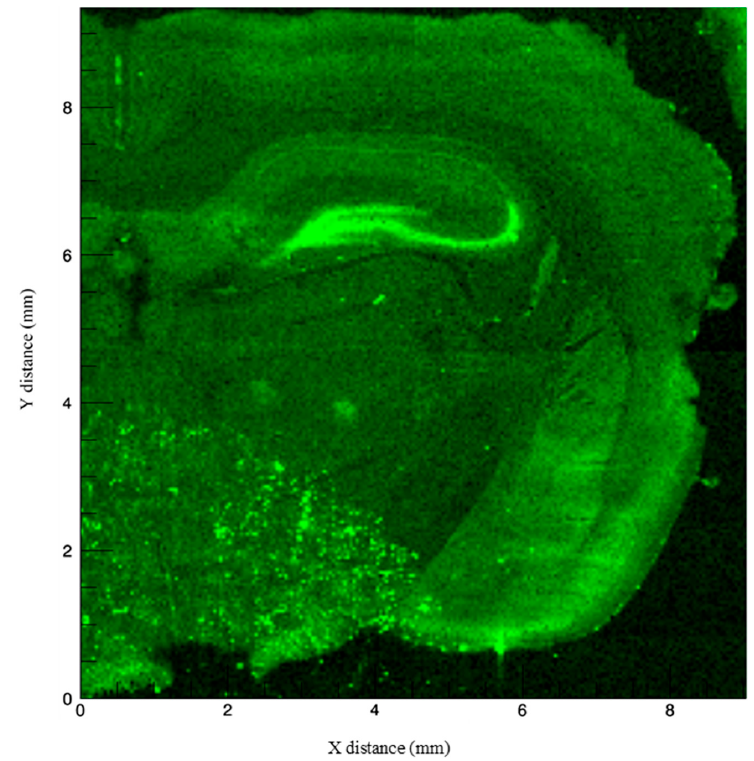
Figure 4. Fluorescence intensity of Zn normalized to the incident X-ray intensity. The strongest signal arises in the granule cell layer of the dentate gyrus and the CA3 pyramidal cell layer. Notable signal is also seen in the piriform cortex (lower right cortical regions of the hemisphere).